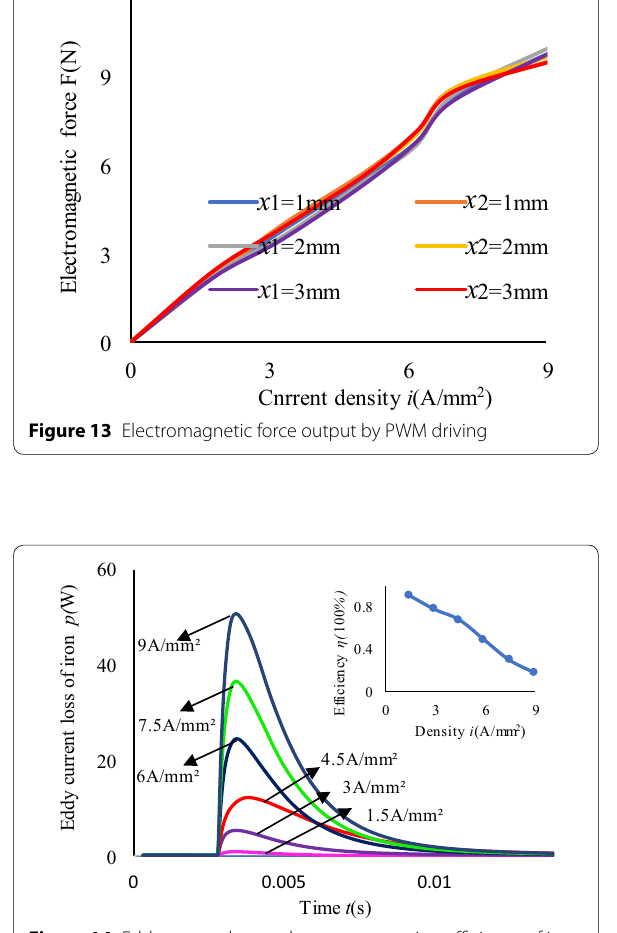
Figure 14 Eddy current loss and power conversion efficiency of iron core